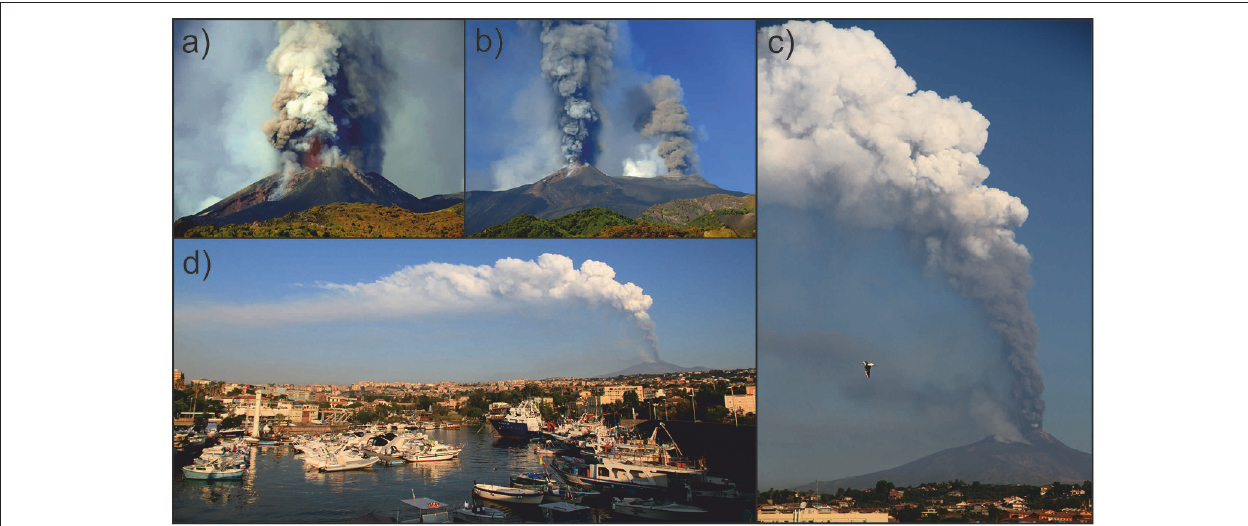
FIGURE 3 | Images showing the evolution of the eruption plume of the 25-26 October 2013 paroxysm between 07:00 and 12:00 of 26 October. (a) Lava fountaining and associated steam, ash and tephra plumes; (b) fountaining jets at the NSEC (left) and coeval dense ash plume from the NEC (right); (c) the dark gray eruption column rising above the NSEC and culminating into a whitish, gas-enriched volcanic plume viewed from S; (d) eruption plume extending to the west of the volcano viewed from the Ognina harbor in Catania. Photos by B. Behncke (a,b) and D. Andronico (c,d) .